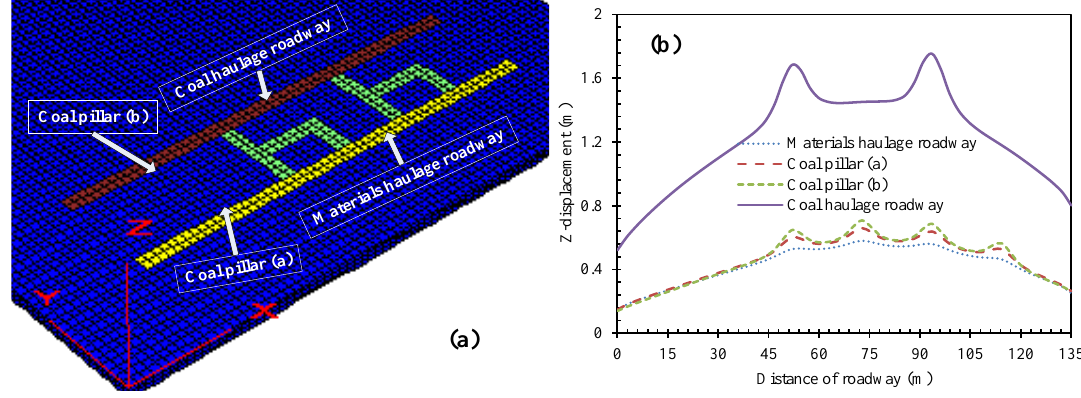
Figure 13. Z-displacement when mining distance 140 m . ( a ) Position of monitoring points; ( b ) Displacement of each position.